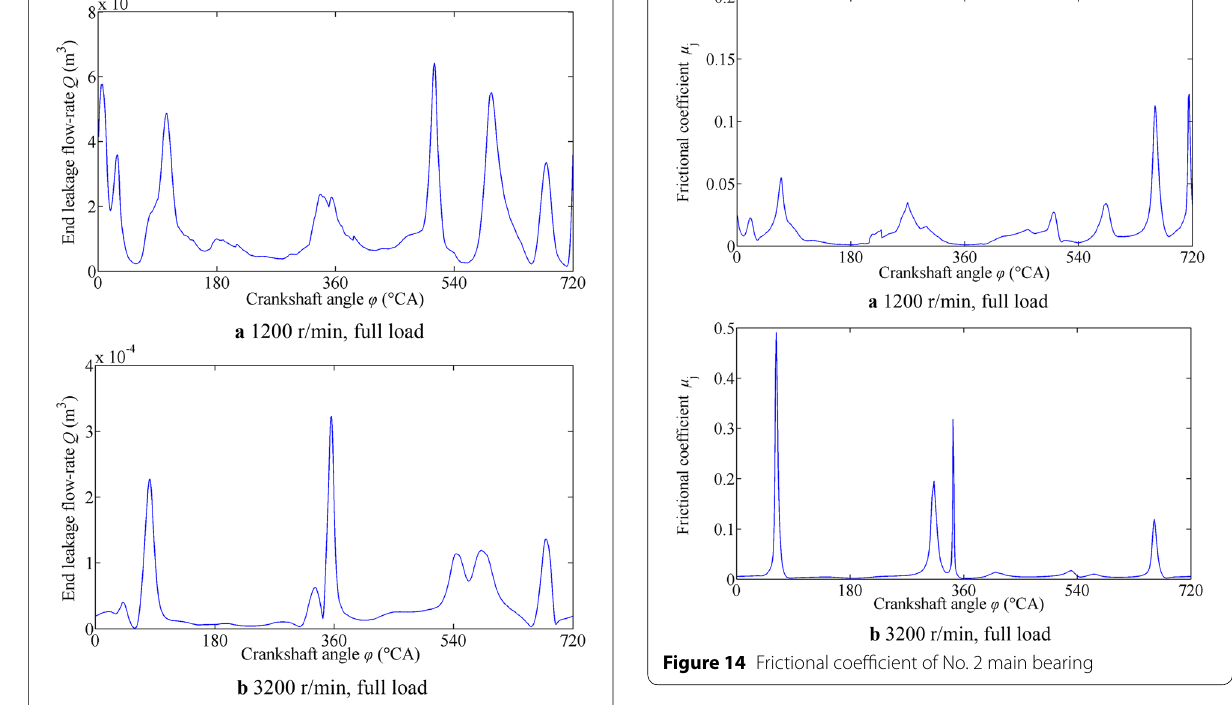
Figure 12 End leakage flow-rate of No. 2 main bearing